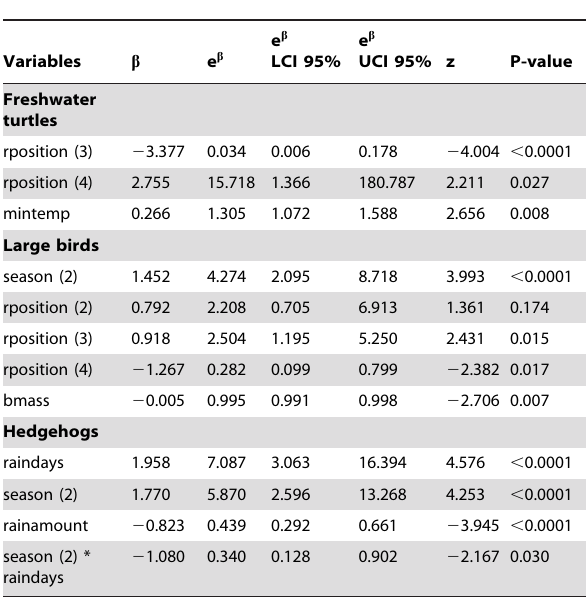
Table 6. Multivariate Cox hazards models for Freshwater turtles, Large birds, and Hedgehogs ( b : coefficients, e b : hazards ratio, e b LCI 95%: 95% lower confidence interval for hazards ratio, e b UCI 95%: 95% upper confidence interval for hazards ratio, z: Wald test, P-value: significance of Wald test, for variables definition, see table 8).